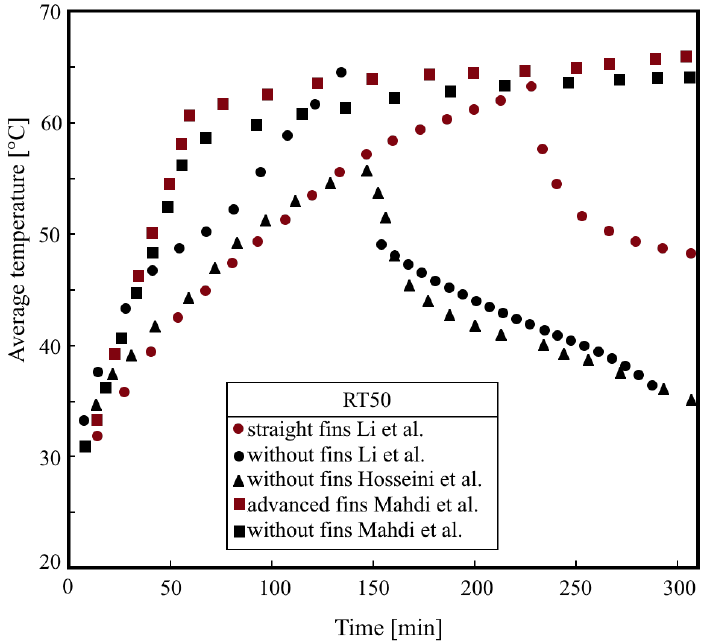
Figure 8. Influence of fins on PCM temperature in DTH TESUs [34,59,62].